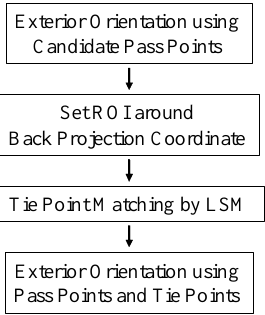
Figure 8. Tie Point Matching